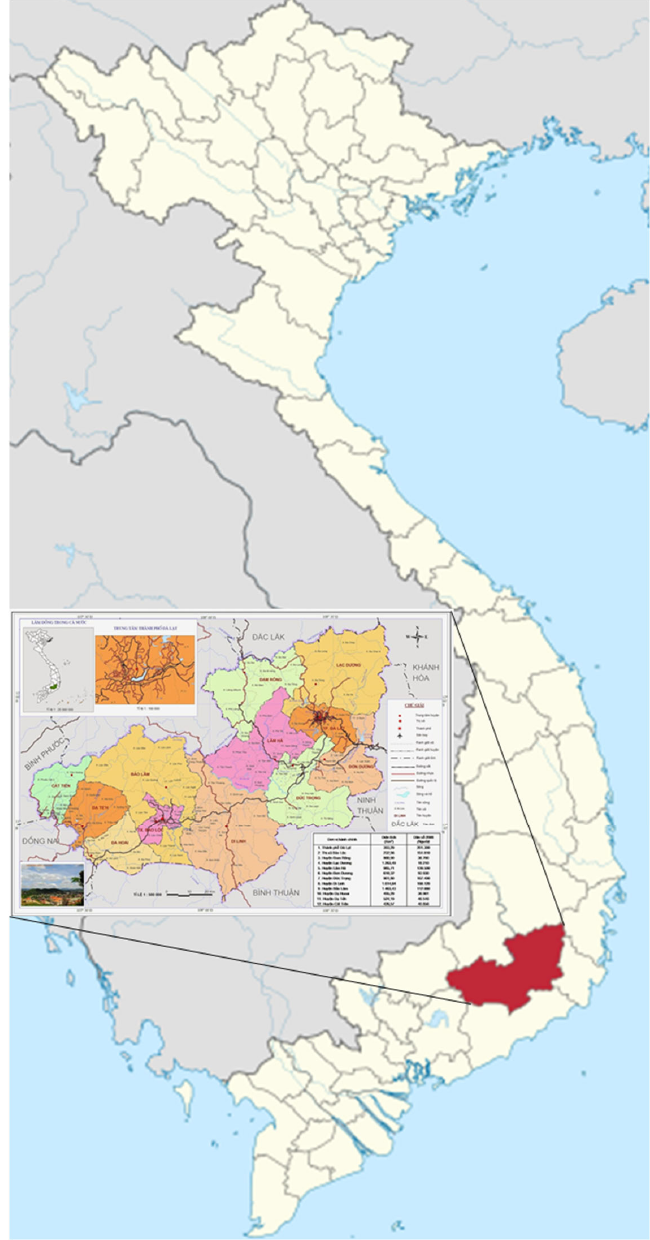
Figure 1. Map of research area.